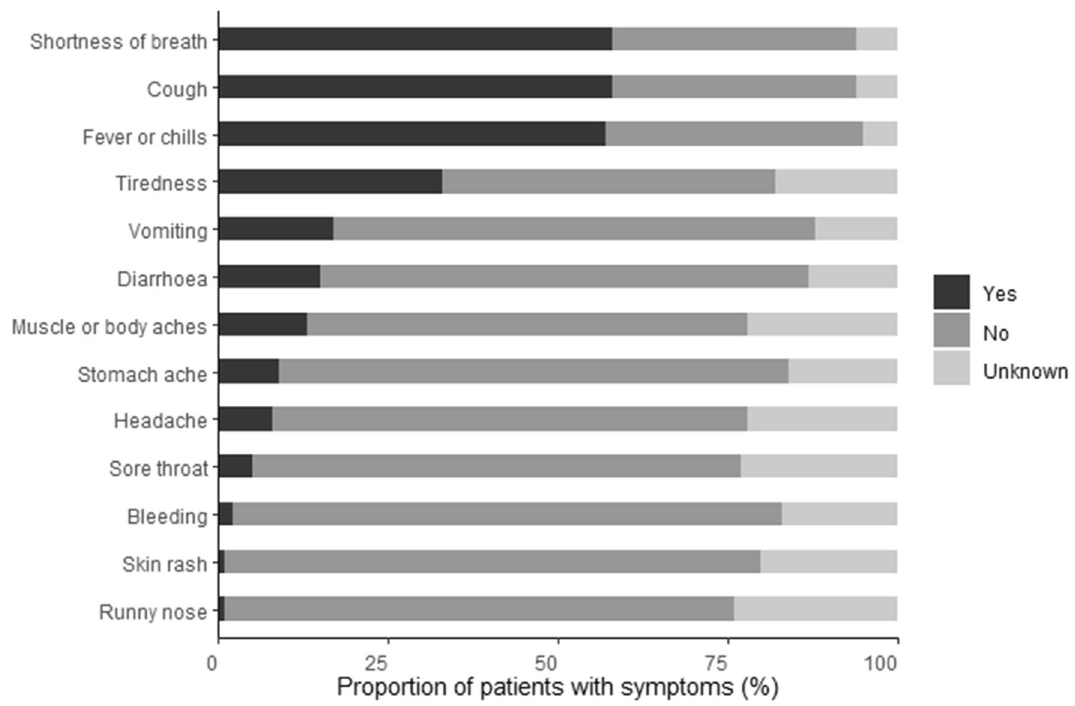
Figure 2. Actual symptoms of COVID-19 experienced by infected individuals in the UK at the time the survey was conducted. ( Source : Welsh Government—Technical Advisory Group). Unknown refers to instances where it was not possible to state whether the symptom was experienced or not.